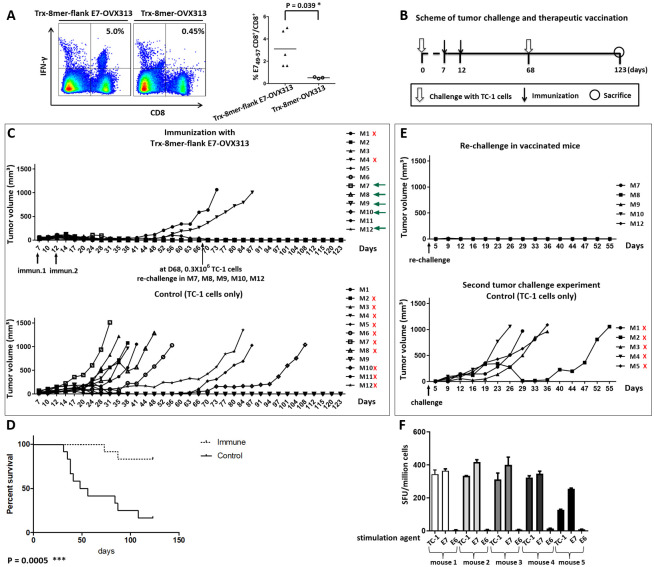
Vaccination with Trx-8mer-flank E7-OVX313 suppresses the outgrowth of grafted TC-1 tumors in mice.(A) E7-specific CD8+ T-cell responses were evaluated using H2-Db/E749-57 streptamer staining. Splenocytes from immunized mice were double-stained with an anti-CD8-PE antibody and an APC-conjugated H2-Db/E749-57 streptamer and visualized by flow cytometry. Representative raw data for two mice are shown in the left panels; the percentages of IFN-γ-producing CD8+ T cells are shown in the upper right quadrant. The diagram on the right shows the cumulative data obtained from the experiments performed with the streptamer; each symbol represents one mouse; the mean percentage (E749-57–specific CD8+ T cells/total CD8+ T cells) is indicated by horizontal bars. (B) Experimental scheme of tumor challenge and therapeutic vaccination. (C) Tumor growth curves of vaccinated and unvaccinated mice (12 mice per group). (D) Animal survival rate shown by Kaplan-Meier curves; the Log-rank test indicates a significant difference in survival (p = 0.0005). (E) Tumor growth kinetics after re-challenge. Sixty-eight days after inoculation of tumor cells, five vaccinated mice (indicated by green arrows in Fig 7C) were re-challenged with 0.3×106 TC-1 cells. As a reference and internal control, five naïve mice were implanted in parallel with the same amount of TC-1 cells. Red crosses indicate mice that had to be sacrificed ahead of time due to an excessive tumor burden (tumor diameter over 1.5 cm). (F) A potent E7-specific T-cell response is apparent in vaccinated, tumor-regressed mice. Numbers of IFN-γ spots per 106 splenocytes are determined. Splenocytes were stimulated with TC-1 cells, E749-57 or E648-57 [37] peptide. Shown are the mean and SD of triplicate values on each mouse under the specific stimulation agent.